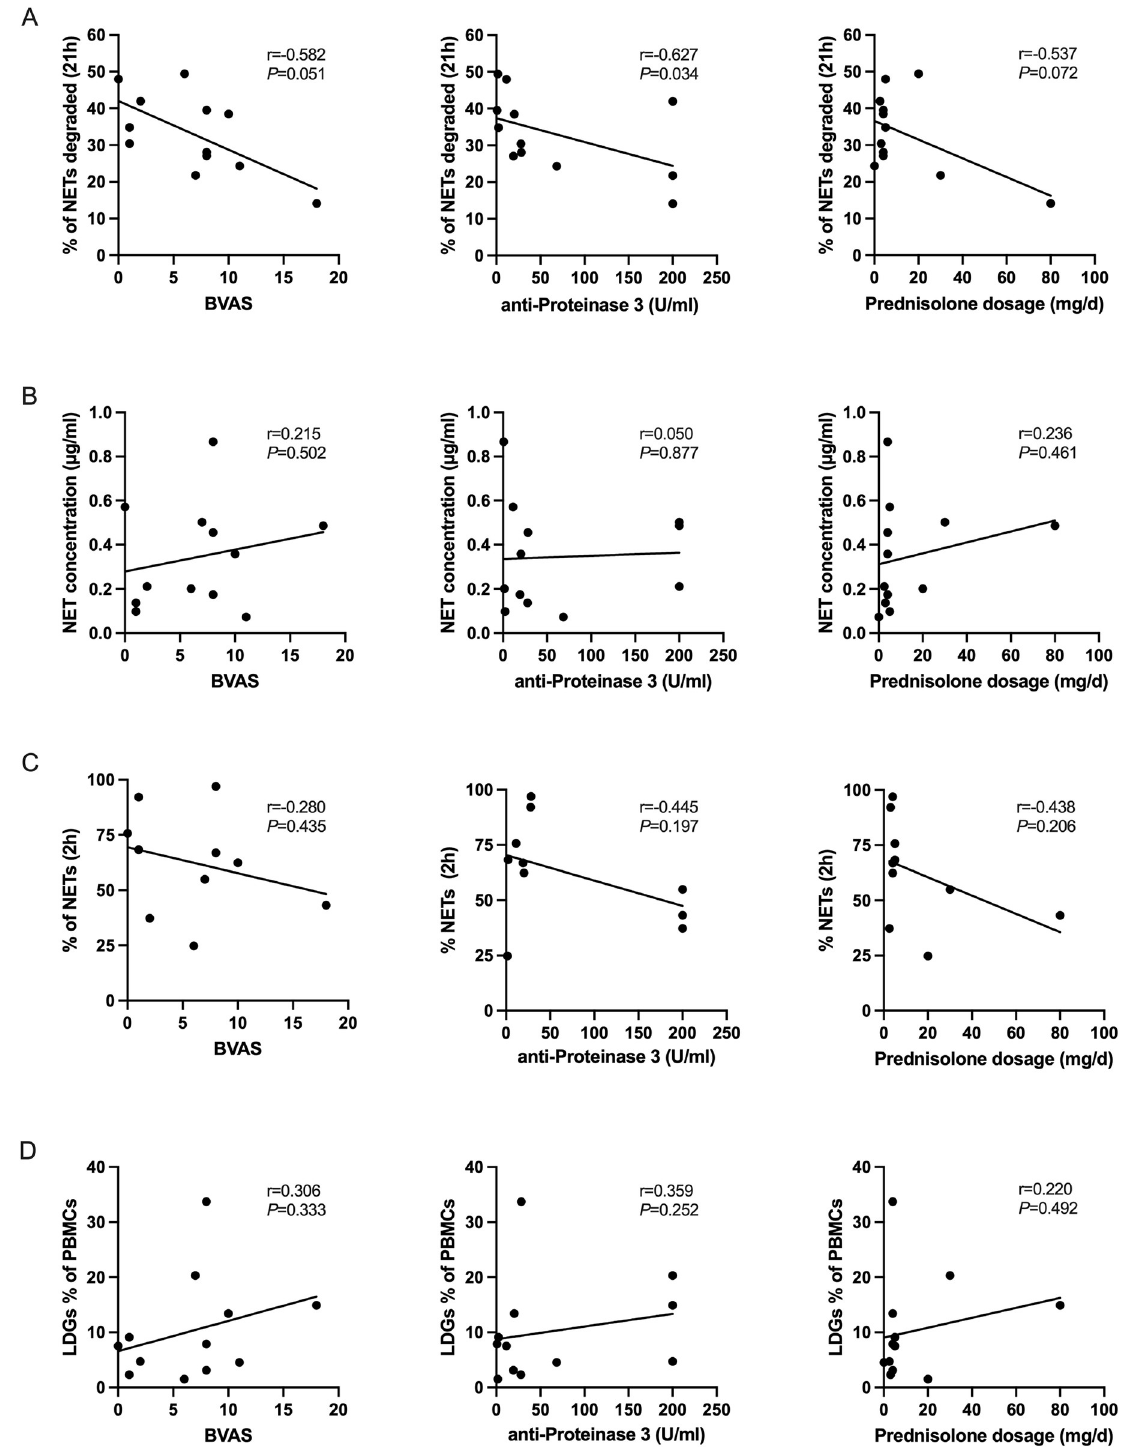
Fig 5. Correlation of NET-degradation, NET-concentration, NET formation of NDGs, and periperal blood LDG levels with clinical and serologic activity measures in GPA, as well as daily prednisolone dosage. Spearman-correlations of (A) NETs-degradation-activity after 21 hours of incubation, (B) NET-concentration in peripheral blood as measured by ELISA, (C) frequency of NET formation of NDGs after 2h of PMA stimulation and (D) LDG levels in peripheral blood with BVAS, anti-PR3 titer in serum, as well as daily prednisolone dosage. Each dot represents one measured patient sample. Correlation-coefficient and P -value are depicted in the figure ( α = 0.05).